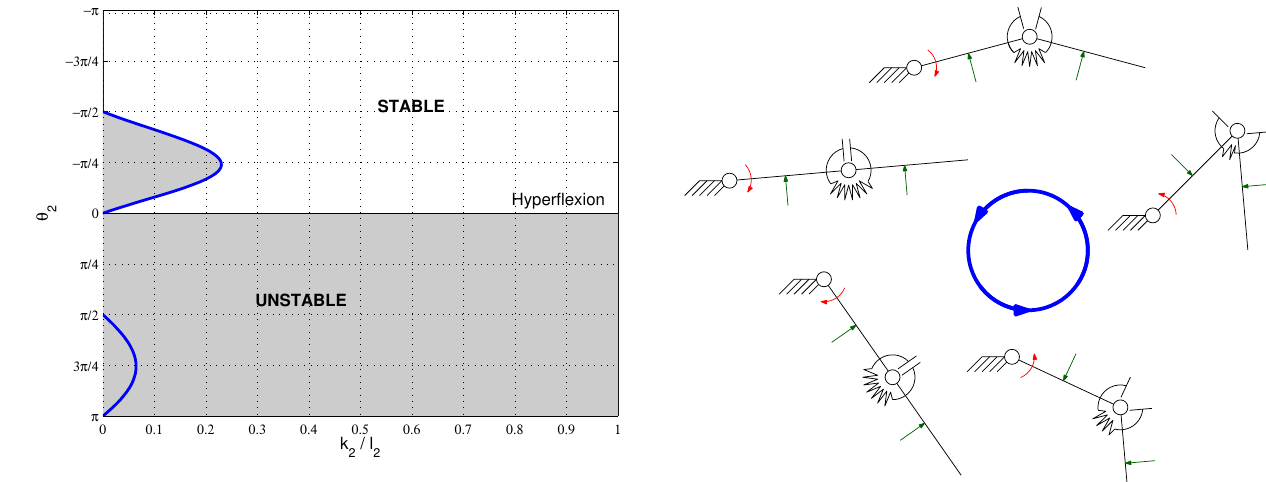
Figure 6. Initial grasp-state plane of Da Vinci’s finger.